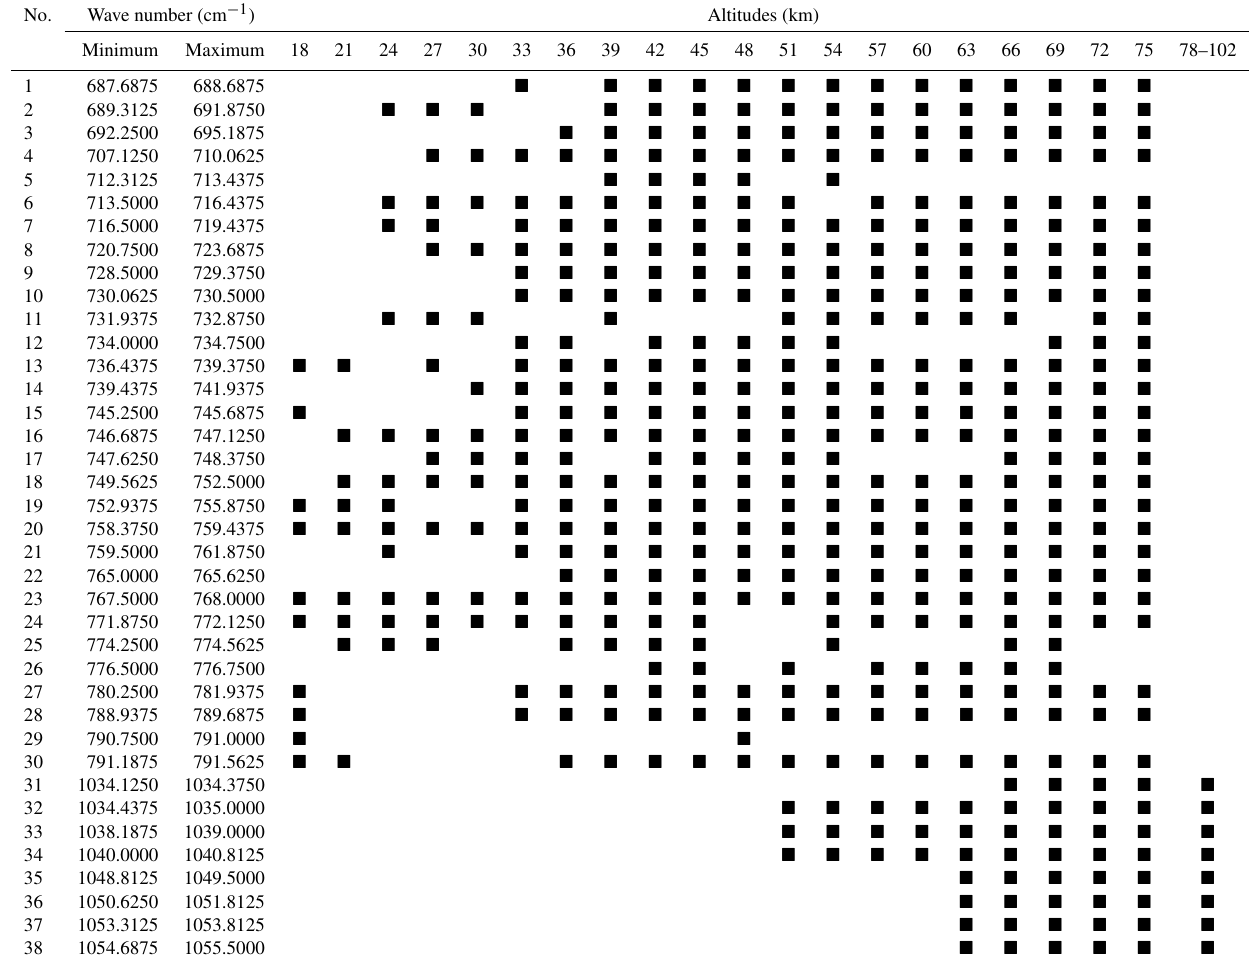
Table 3. Microwindows and altitude ranges used in the retrieval of MIPAS ozone V5r_O3_m22. No. Wave number (cm − 1